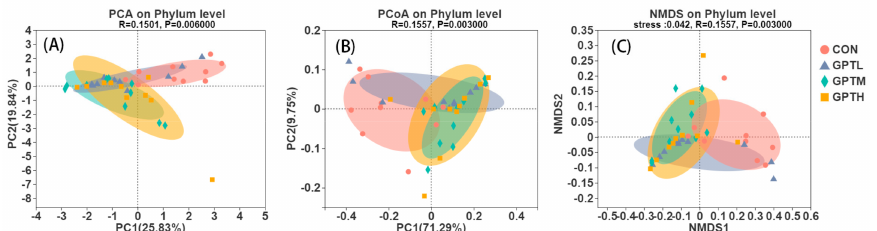
Figure 5. PCA( A ), PcoA ( B ) and NMDS ( C ) plots of microbial communities were based on phylum level; each treatment group is represented by a different color ( n =